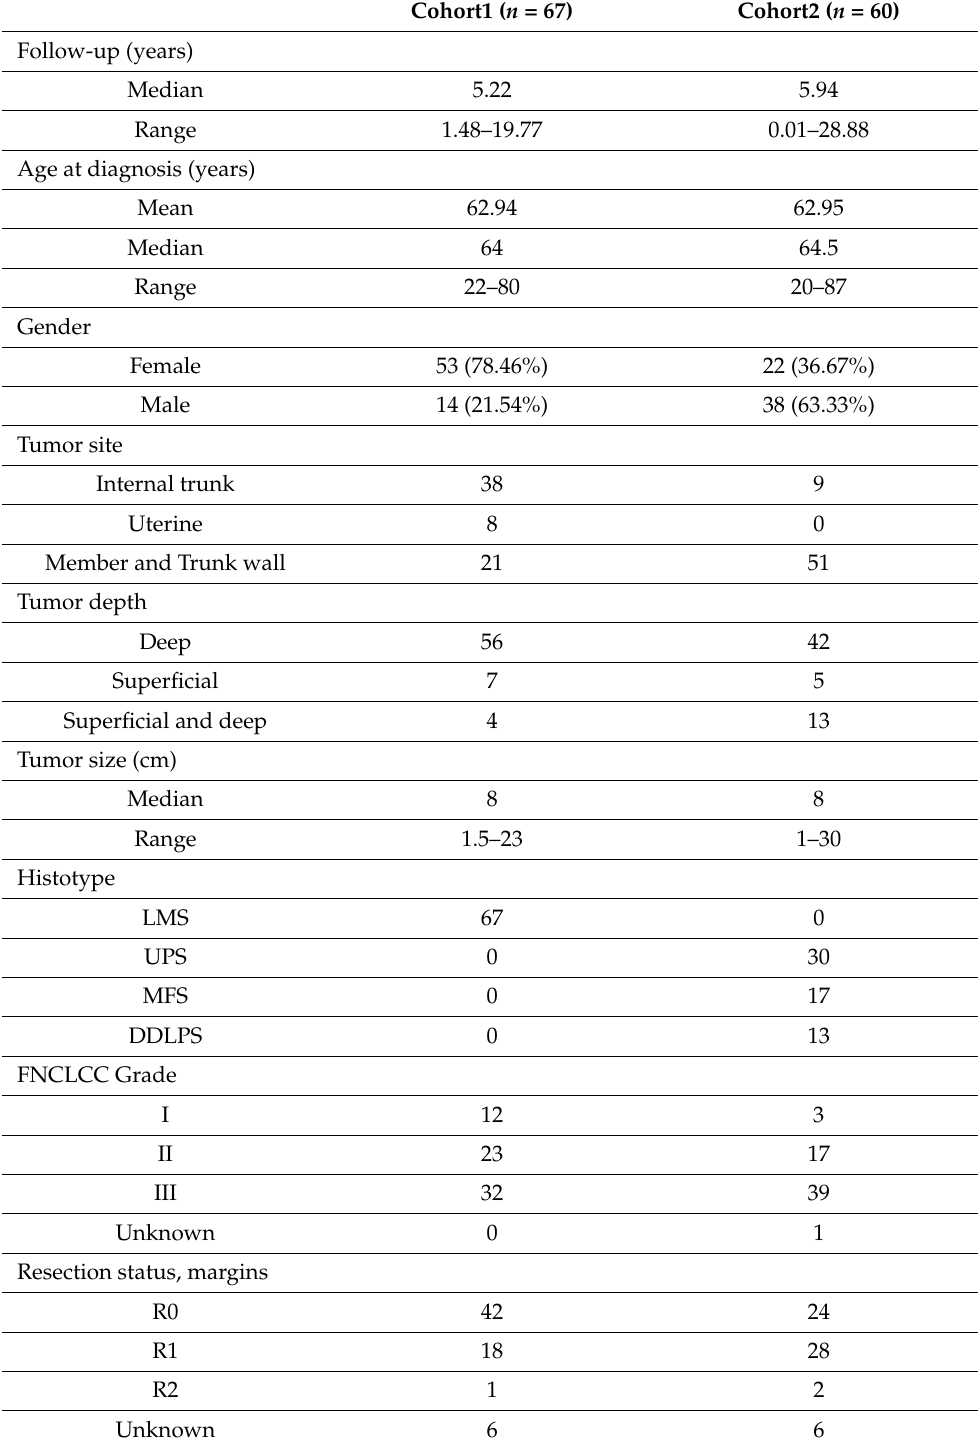
Table 1. Clinical characteristics in both cohorts, related to Figures 1 and 3. LMS, leiomyosarcoma; UPS, undifferentiated pleomorphic sarcoma; MFS, myxofibrosarcoma; DDLPS, dedifferentiated